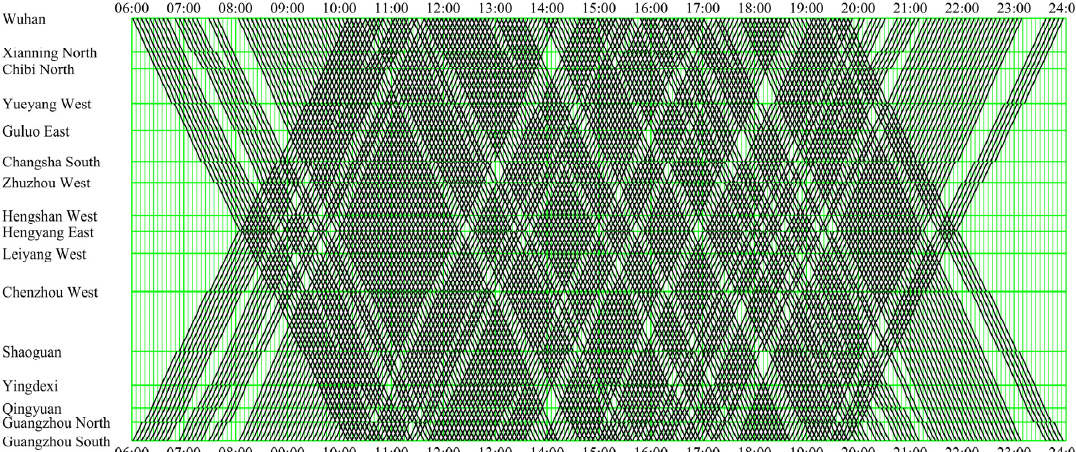
Figure 7. Train timetable ( |𝐿| = 100 ). 6.2.2. Analysis of the Turnaround Efficiency of Rolling Stock The turnaround time of a rolling stock unit determines its turnaround efficiency. Fig- ure 8 shows the number of trains served by a rolling stock unit and the average time for one turnaround. As shown, there are 95 rolling stock units in service. We observe that a rolling stock unit with a shorter turnaround time can serve more trains. There are 67 roll- ing stock units whose turnaround times are within 40 min, accounting for 70%. The num- ber of rolling stock units serving 4 trains is 10, and their average turnaround time is about 20 min, which is equal to the minimum turnaround time. This indicates that the connec- tion efficiency of rolling stock is extremely high. The number of rolling stock units serving 3 trains is 78, and their average turnaround time is 33 min. The number of rolling stock units serving 2 trains is 5, and their average turnaround time is 69 min, which is relatively long but acceptable. Besides, there are 2 rolling stock units that only serve one train, so there is no turnaround process. In general, the turnaround times of rolling stock are short or acceptable, and the turnaround efficiency is high.